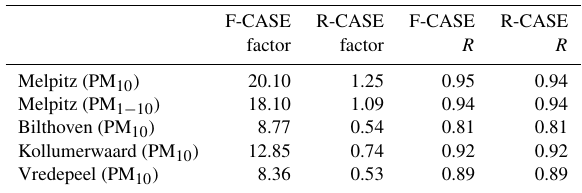
Table 3. Comparison of WRF-Chem modeled Na + mass concen- tration results with four EMEP stations measurements. The factors (simulation/measurement) and correlation coefficient ( R ) are shown for the F-CASE and the R-CASE,